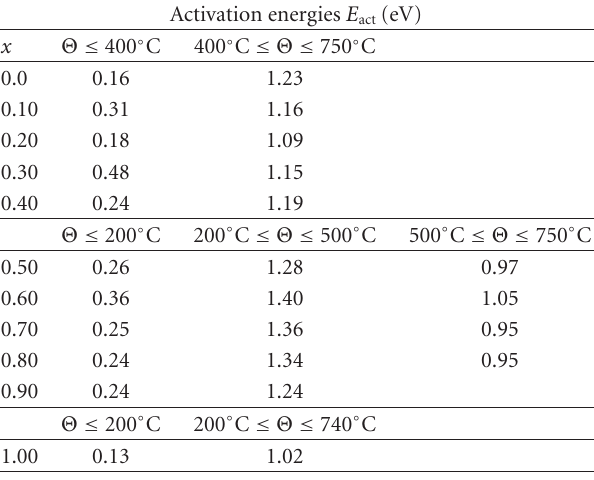
Table 3: Values of activation energies E act as a function of composition x and